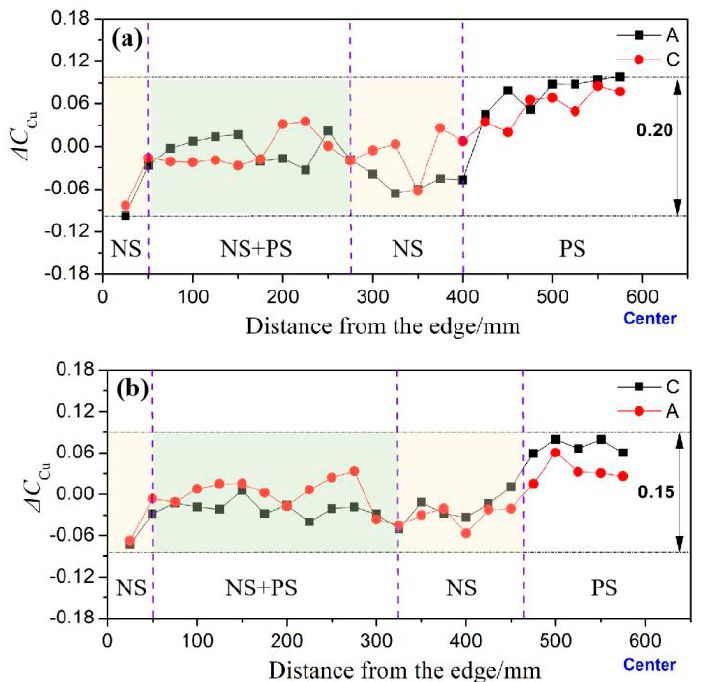
Figure 7. Segregation rate distribution of Cu element on the cross-section of the two ingots. ( a ) Casting ingot I, ( b ) casting ingot II.